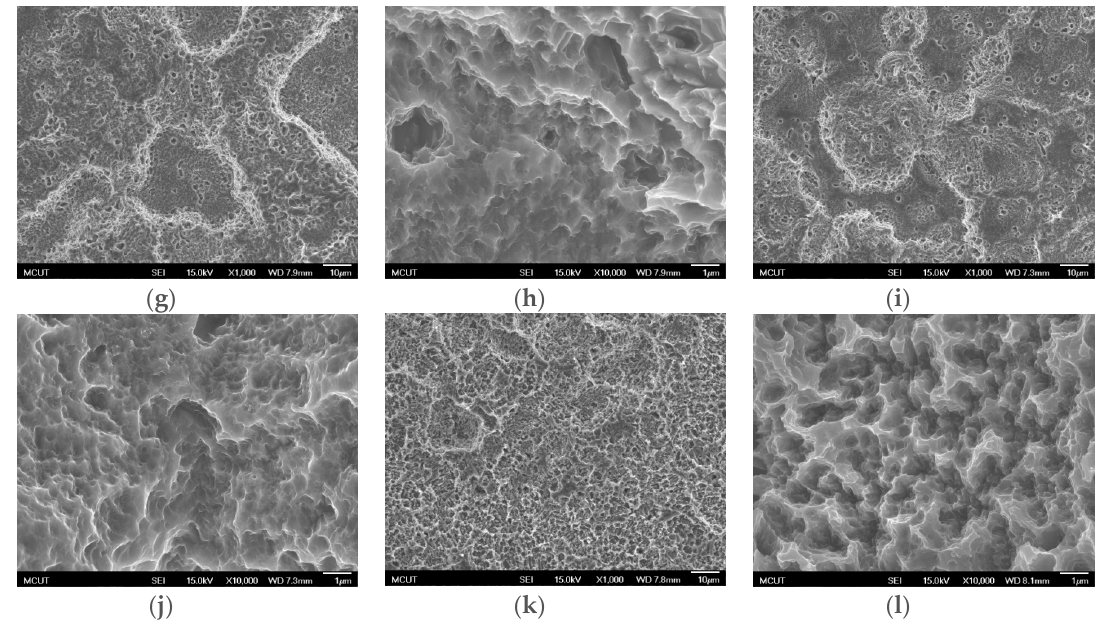
Figure 10. SEM images of the CP Ti surface etching in H 2 SO 4 /HCl at different temperatures. ( a ) H 2 SO 4 (90 °C)/HCl (80 °C) (1000× magnification); ( b ) H 2 SO 4 (90 °C)/HCl (80 °C) (10,000× magnification); ( c )